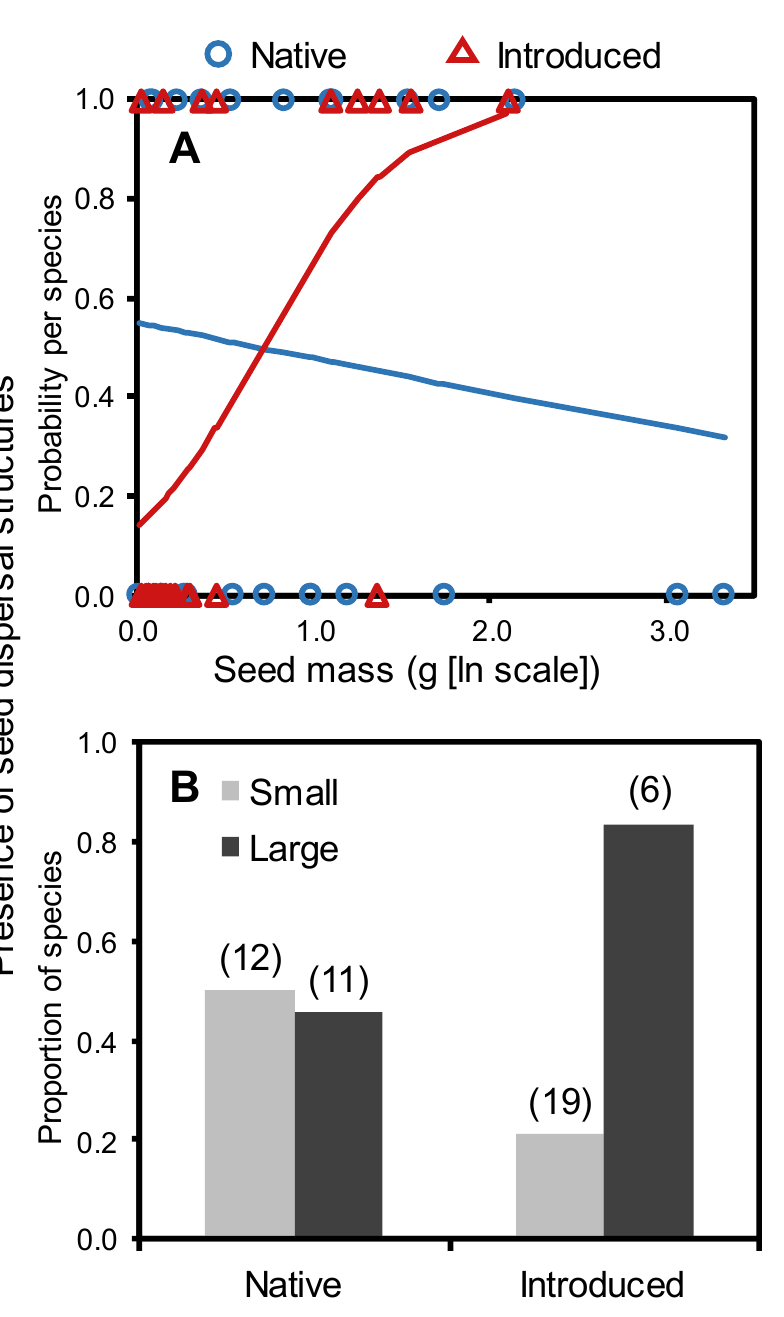
Figure 1. Relationship between seed mass (ln [mg + 1]) and the presence of seed dispersal structures, as compared between 23 native and 25 introduced grassland species in Montana, USA, in two analyses. ( A ) The dispersal structure-seed mass relationship varied significantly by species origin when all species were tested together (see text), with introduced species showing a positive relationship and native species trending in the opposite direction, as represented by solid lines indicating predicted probabilities. Note that the relationship was significant for introduced species when tested alone ( F 1,23 = 5.6, p = 0.027), but not for native species ( F 1,21 = 0.4, p = 0.56). Open symbols represent observed values (1 = species with seed dispersal structure, 0 = without). ( B ) The proportion of species with dispersal structures was four times higher for large (>1.5 mg [ln scale: >0.9 mg]) vs. small-seeded exotics but did not differ between seed mass categories for native species (see text). Sample sizes (number of species) are shown above bars.